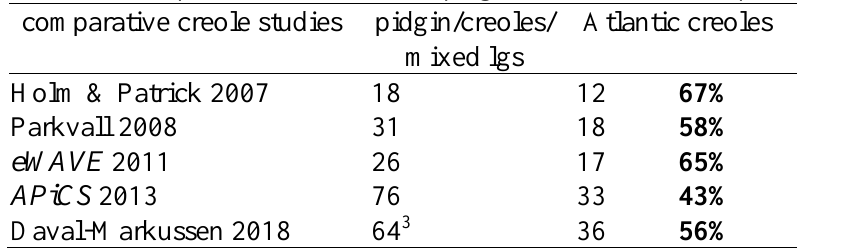
Table 1. Overrepresentation of Atlantic pidgins and creoles in comparative studies* comparative creole